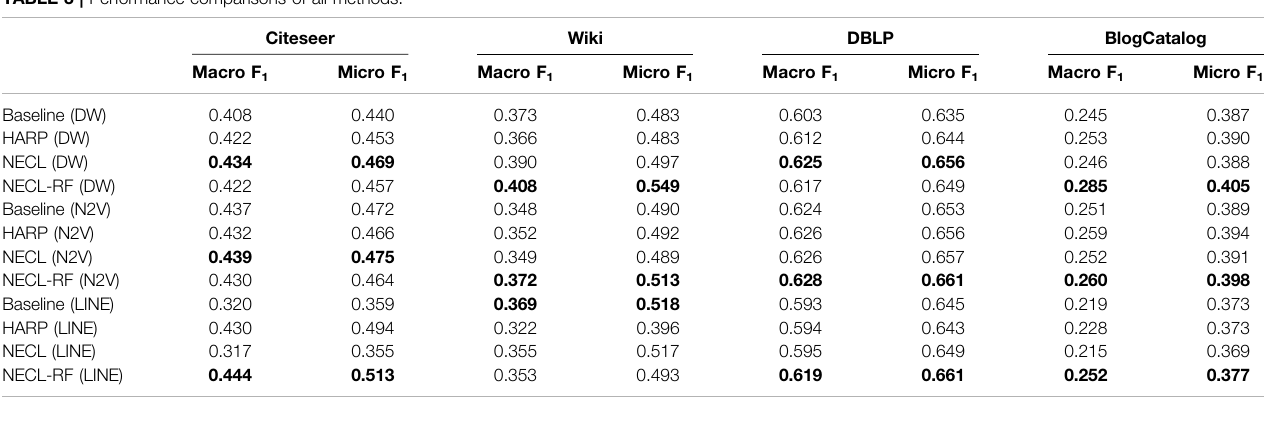
TABLE 3 | Performance comparisons of all methods.